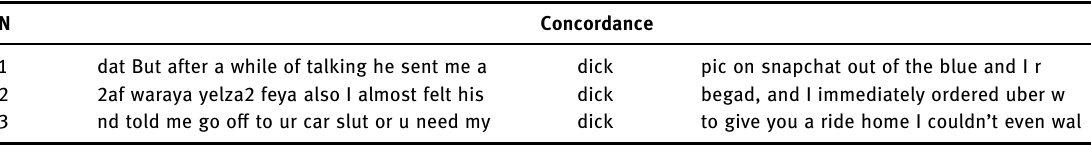
Table 48: Concordance lines for dick